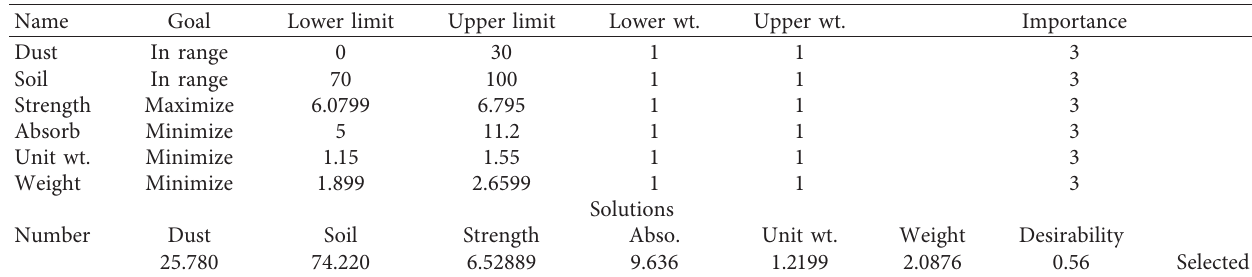
Table 12: Selected ratios of